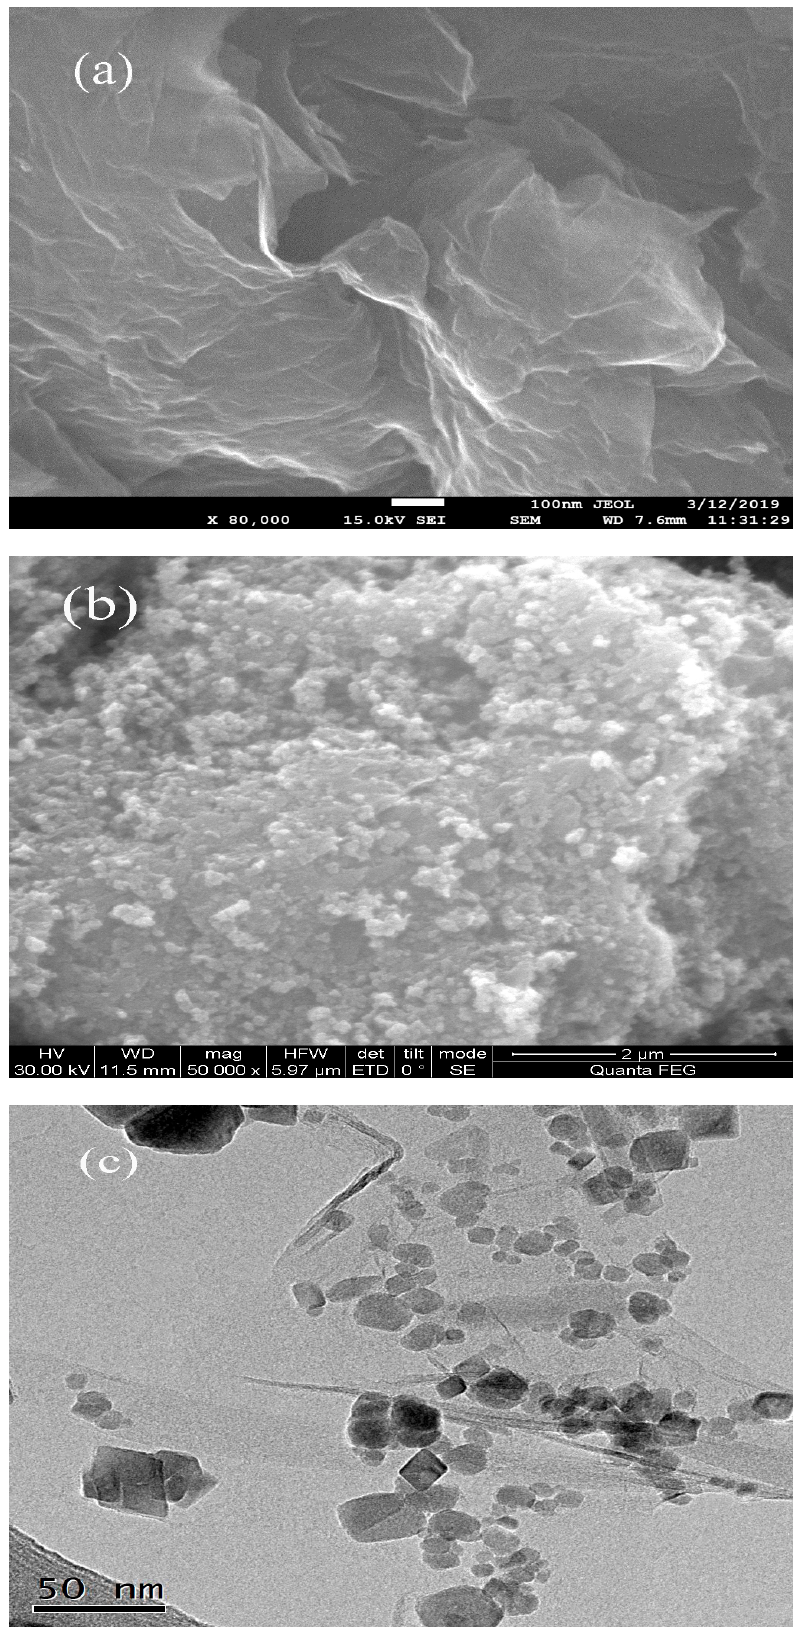
Figure 1. SEM images of GO ( a ) and GO / Fe 3 O 4 ( b ), and TEM image of GO / Fe 3 O 4 ( c